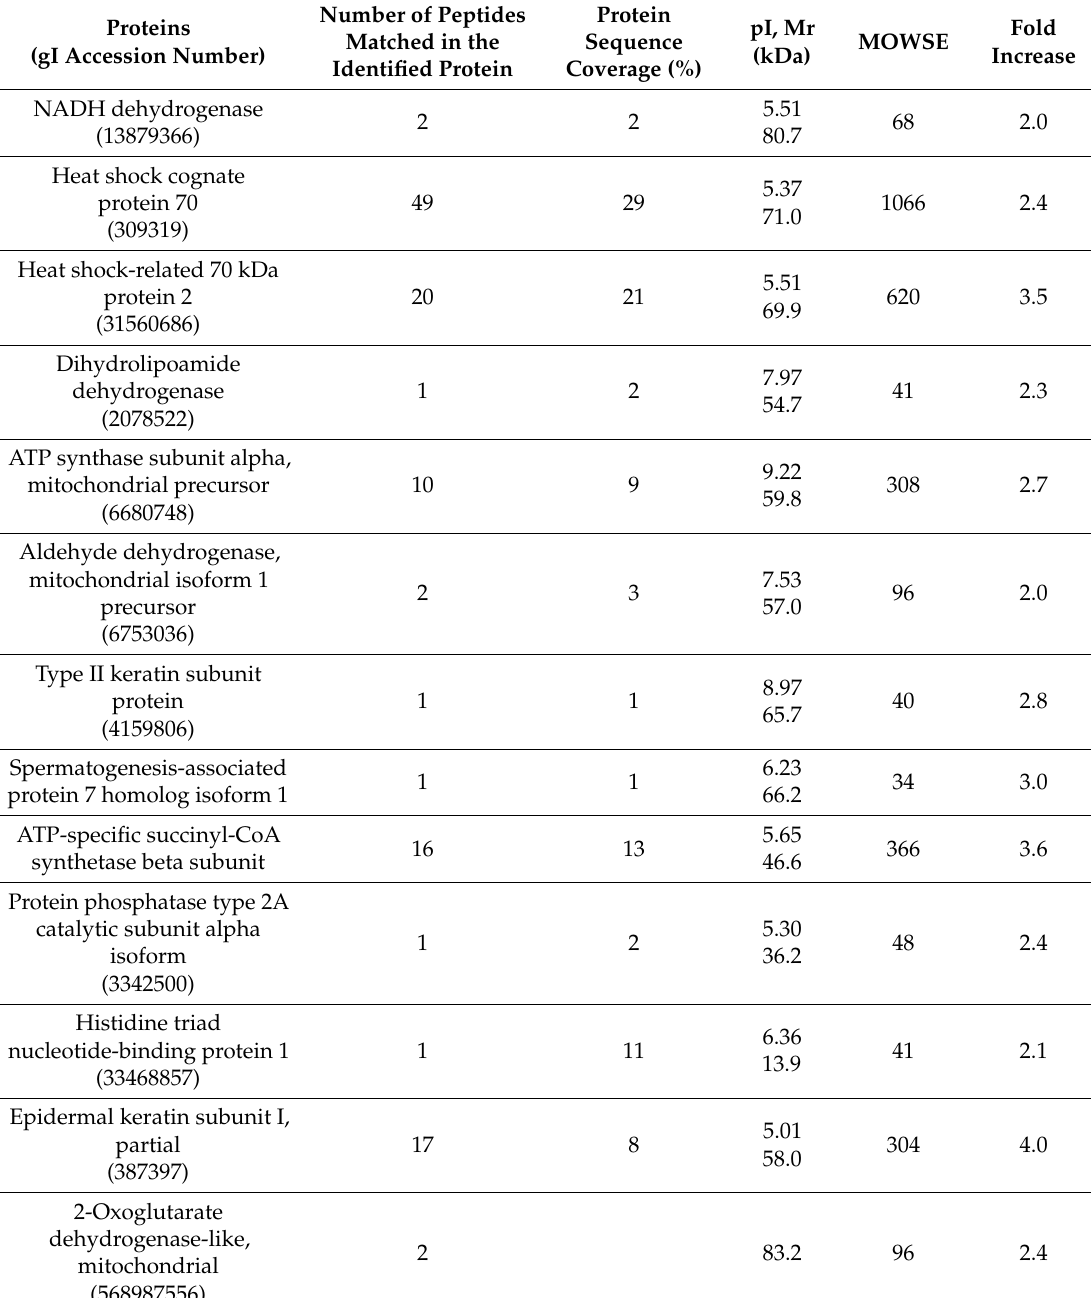
Table 2. Identified candidate proteins in hippocampal homogenates increased after pyridoxine-deficient diet treatment more than two-folds. Note that heat shock cognate protein 70 (HSC70) and heat shock-related 70 kDa protein 2 shows more than 20 peptides matched in the identified protein and protein sequence